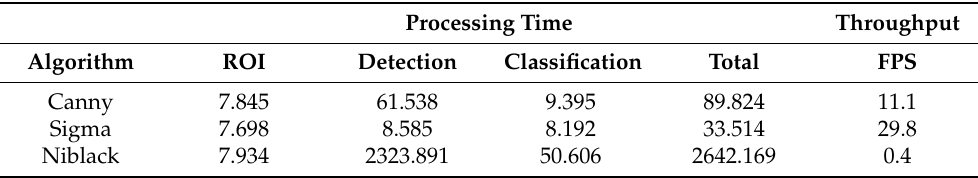
Table 6. Processing time and